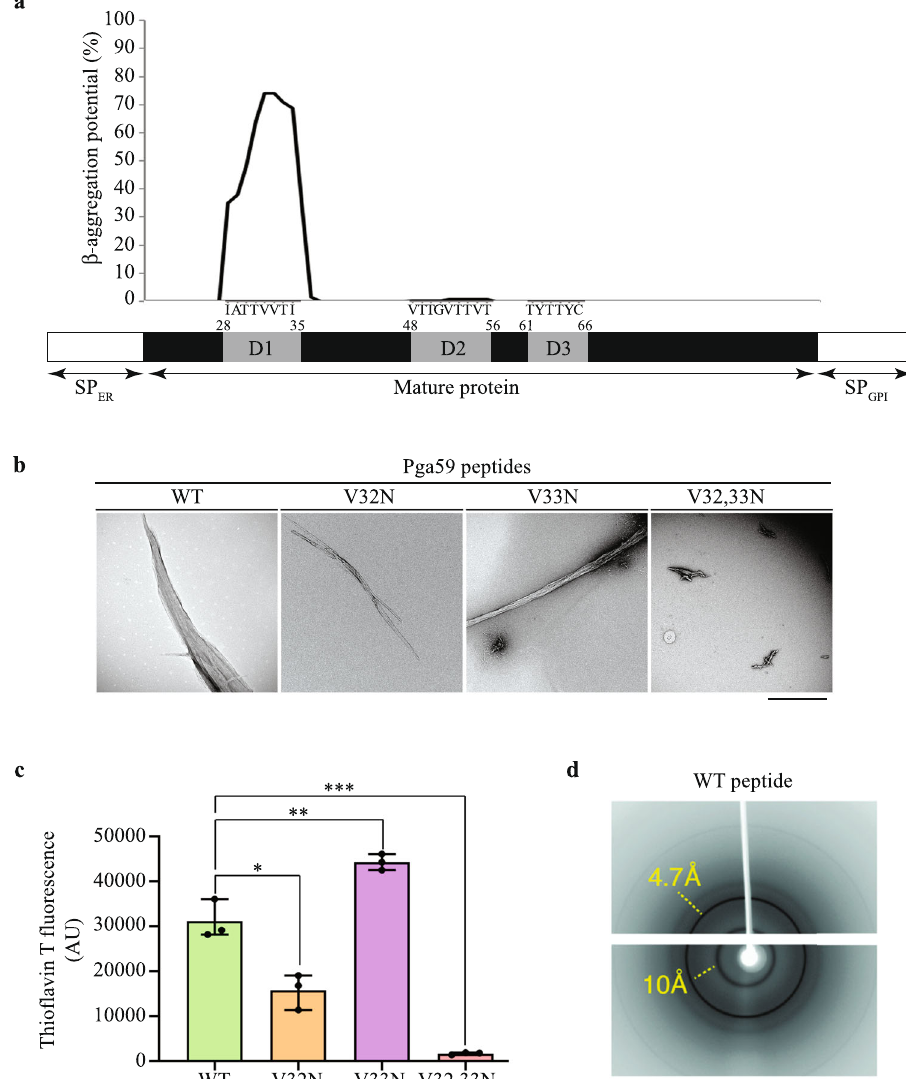
Fig. 1 The D1 domain of Pga59 is suf fi cient to trigger amyloid fi bre assembly in vitro. a The graph shows the TANGO β -aggregation potential of each amino acid in the Pga59 mature region. The amino acid composition of the amyloid-forming regions D1, D2 and D3 is indicated below the graph. Pga59 is sketched under the graph. The black rectangle represents Pga59 full-length protein, and the numbers above indicate the amino acid position encompassing D1, D2 and D3 domains. The SP ER and SP GPI regions correspond to the signal peptides for translocation into the endoplasmic reticulum (ER) and anchorage to a preformed GPI lipid attached to the ER membrane, respectively. The grey boxes named D1, D2, and D3 represent the amyloid-forming domains in Pga59 mature region predicted by TANGO. b , c Wild type and mutant peptides of Pg59 were resuspended in DMSO prior to their dilution in Tris buffer. After 16 h at 37 °C, peptides were analysed with transmission electron microscopy and ThT staining. b D1 peptides were dropped on electron microscopy grids and negatively stained with uranyl acetate. Peptides ’ characteristics are indicated above each micrograph. Scale bar: 500 nm. c ThT intensity of each peptide was recorded at 496 nm. The histogram shows the quanti fi cation of data from three independent experiments. Values are displayed as the averages ± SD . (*) p < 0.05, (**) p < 0.01, (***) p < 0.001. The signi fi cance of the ThT fl uorescence differences were tested using Student ’ s t -test. d X-ray diffraction pat t ern of the quaternary structures formed by the WT D1 peptide. Source data are provided as a Source Data fi